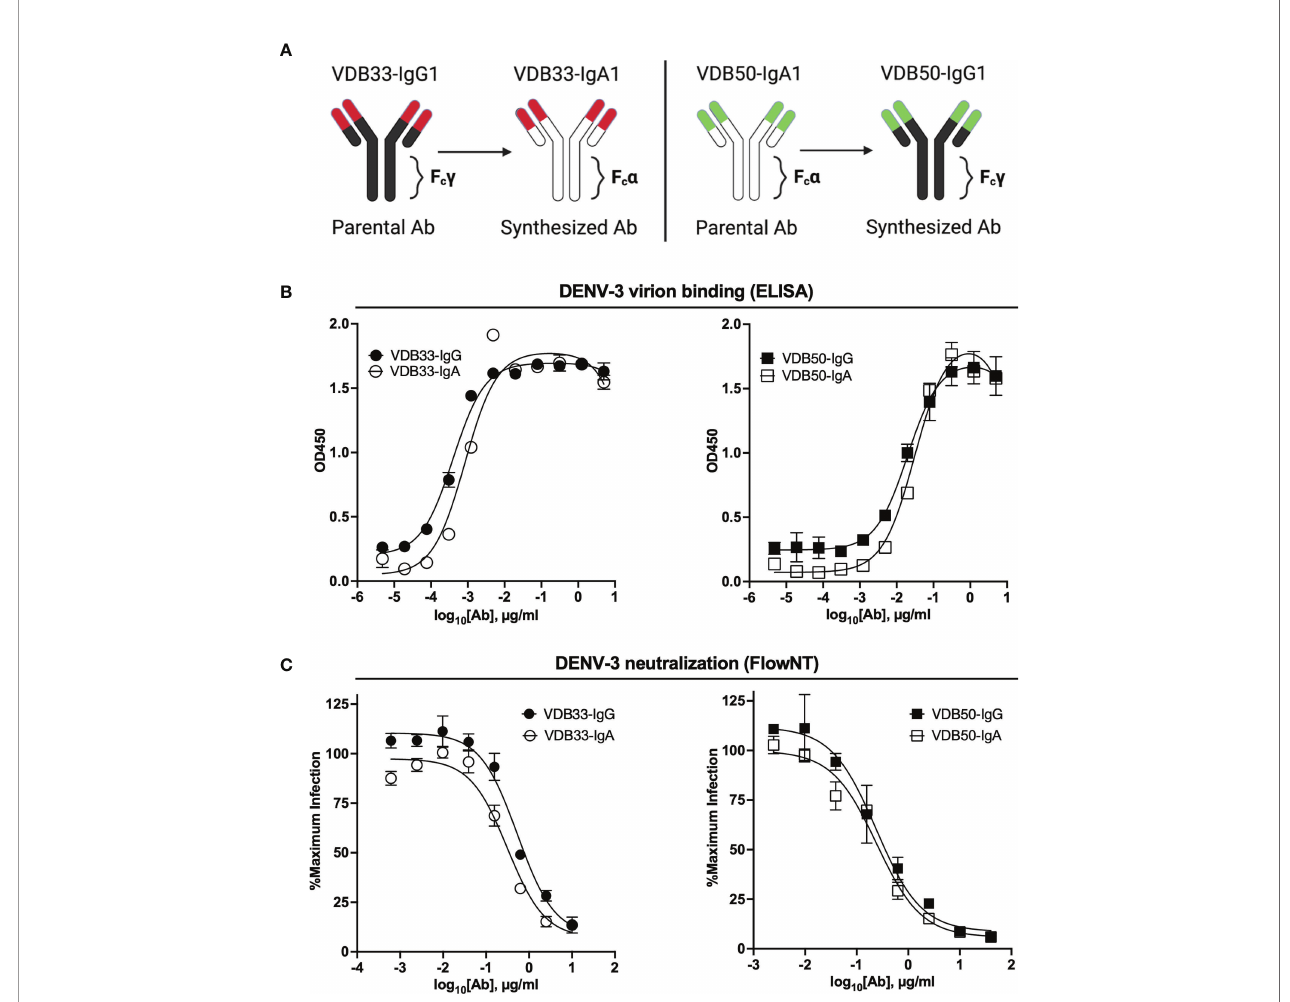
FIGURE 1 | Isotype conversion scheme, DENV binding, and DENV neutralization capacity of VDB33 and VDB50 mAbs. (A) Schematic of isotype conversion of VDB33 and VDB50 from respective parental isotypes, indicating conservation of antigen-binding domains and alteration of Fc domains. (B) DENV-3 binding capability of VDB33-IgG, VDB33-IgA, VDB50-IgG, and VDB50-IgA measured by DENV virus-capture ELISA. (C) DENV-3 neutralization capability of VDB33-IgG, VDB33-IgA, VDB50-IgG, and VDB50-IgA as assessed by FlowNT. Neutralization data are presented as a percent of the positive (no neutralizing mAb) control for each replicate. Error bars +/- SEM. Data are representative of at least 4 independent experiments.